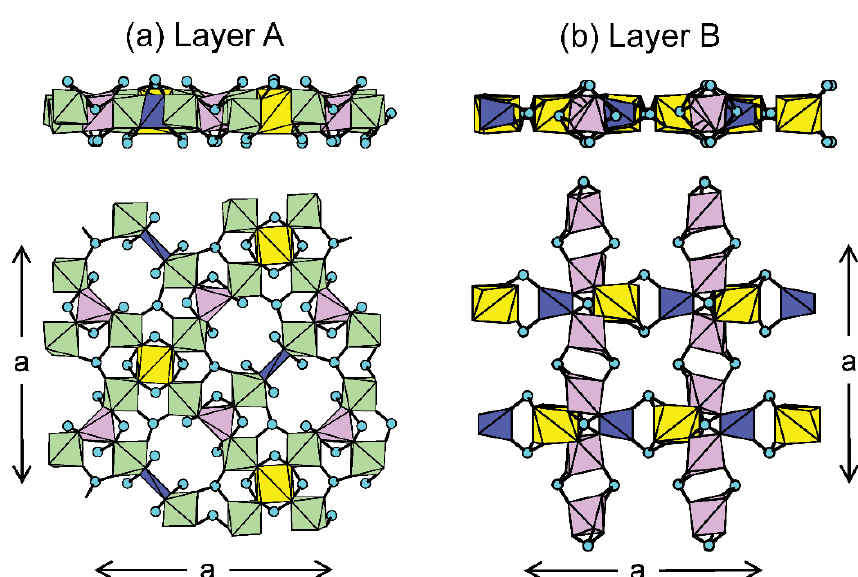
Figure 5. Depiction of individual ( a ) A and ( b ) B layers in magnussonite, in cross-section ( upper ) and in plan view ( lower ).